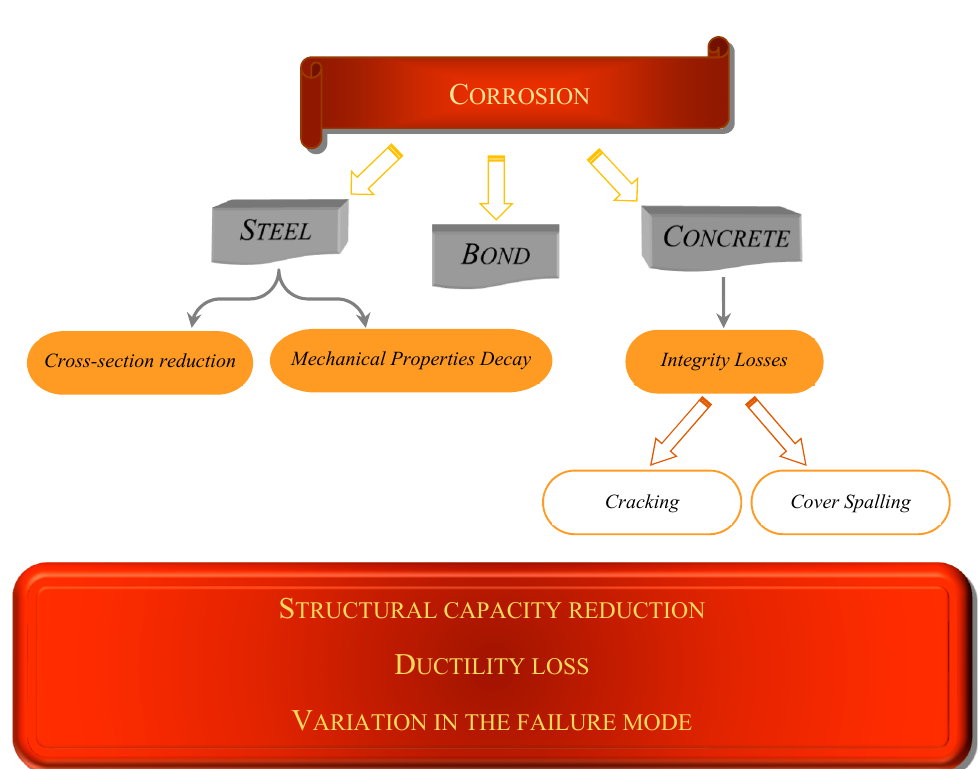
Figure 1. Corrosion influences on the behavior of a structural element.